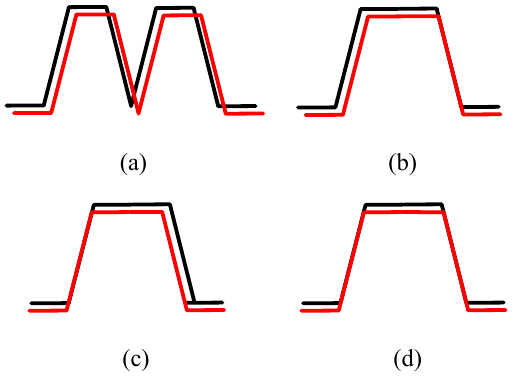
Figure 4. Several examples of typical measurement data of the two parallel ultrasonic